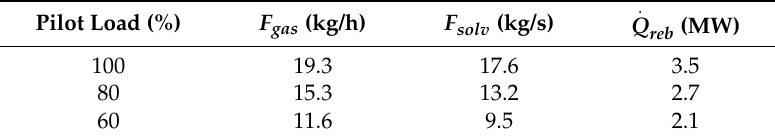
Table 5. Simulated pilot plant inputs’ set points for the three operating points to be studied, corresponding to 100%, 80% and 60% of flue gas mass flow rate capacity of the pilot plant. With Cap = 0.85 and T str = 120.9 ◦ C for all cases.